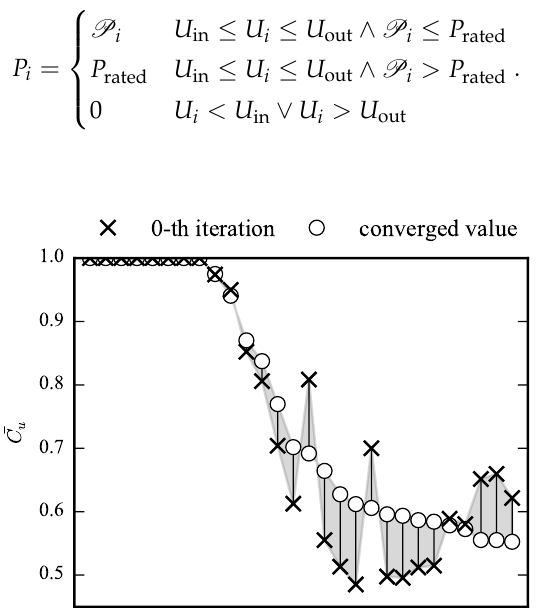
Figure 6. Comparison of the mean coefficient of velocity, ¯ C U , for the 0-th iteration of the DTOcean tidal hydrodynamics model and the converged value (ordered by the converged value). The simulation included 19 TECs with 30